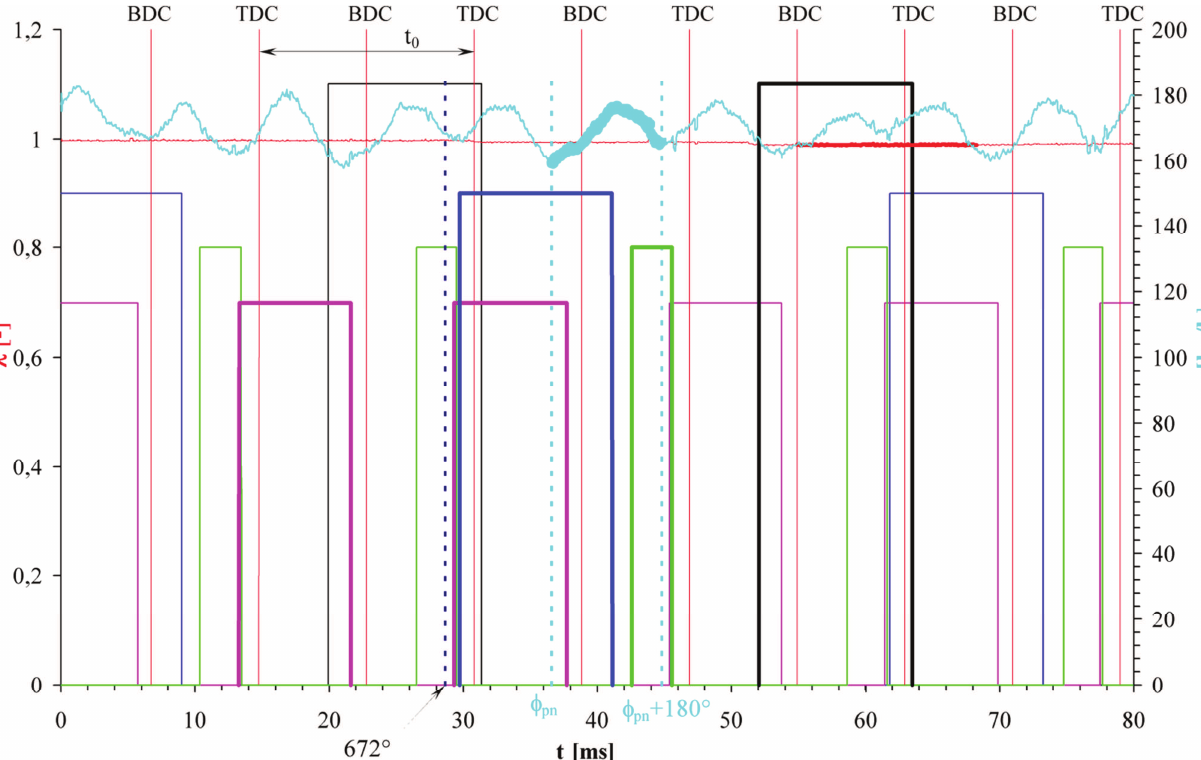
Fig. 1. Processes of chosen signals in the control system of SI engine necessary to determining air mass in each of the cycles of chosen cylinder